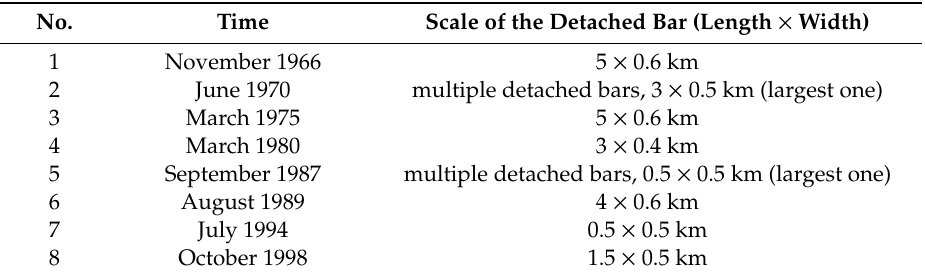
Table 1. Documented splitting events of the Jingjiang Sandbank (JJS) before